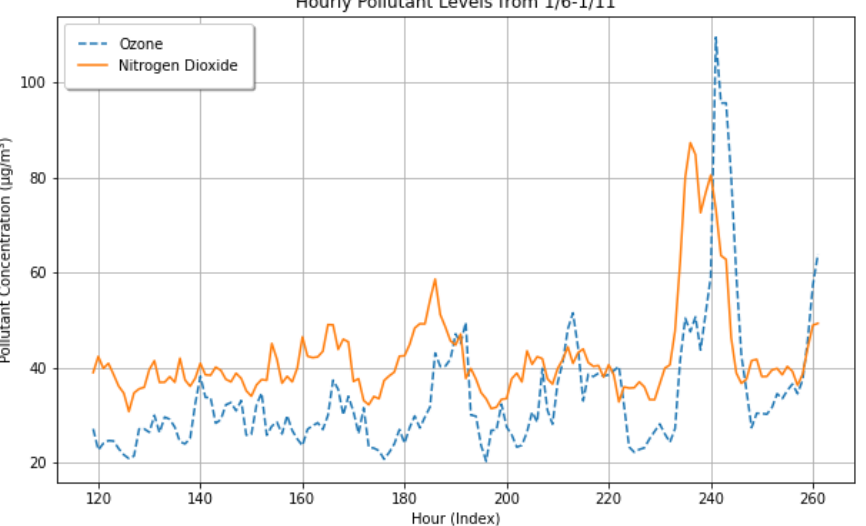
Figure 5. Hourly pollutant levels of ozone (blue) and nitrogen dioxide (orange) in a week in January 2015. Note that peaks in ozone lag nitrogen dioxide by approximately 5